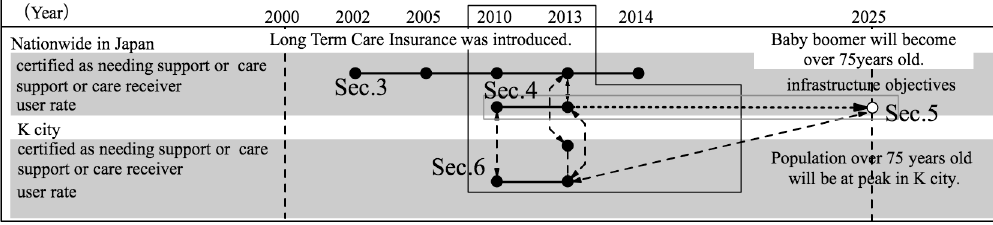
Figure 1. Composition of this paper.